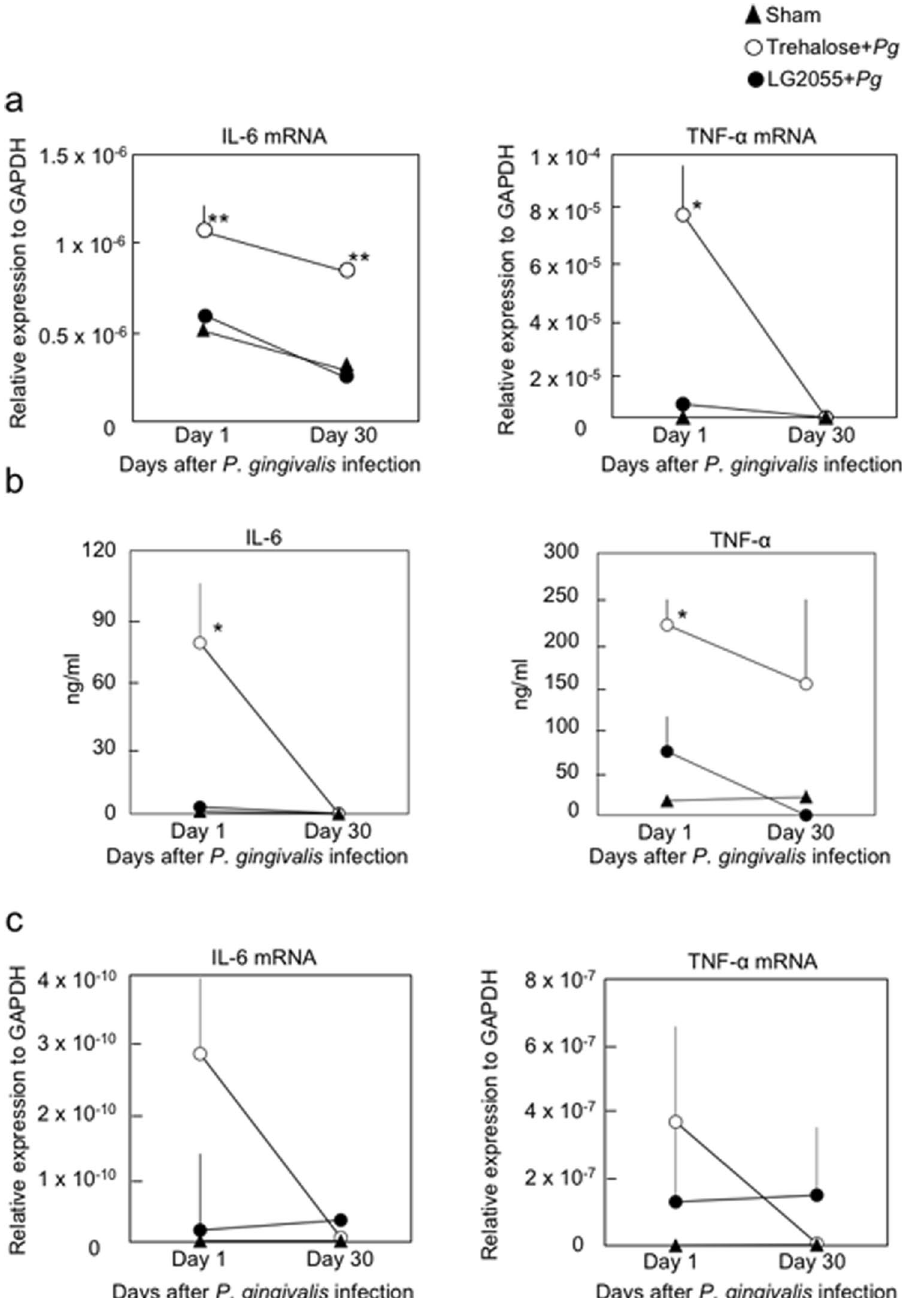
Figure 3. Suppression of the P . gingivalis -induced inflammatory cytokine response in gingival tissues and GMCs by gastric intubation with LG2055. ( a ) Total RNA was extracted from gingival tissue 1 and 30 days after infection with P . gingivalis , and IL-6 and TNF- α mRNA levels were determined using real-time PCR. ( b,c ) GMCs (1 × 10 6 /mL) were isolated 1 and 30 days after P . gingivalis infection, and then cultured for 3 days. ( b ) The culture supernatants were collected and subjected to IL-6- and TNF- α -specific ELISAs. ( c ) The cultured cells were harvested for RNA isolation and quantification of IL-6 and TNF- α mRNA using real-time PCR. All values are presented as the means ± SEM of eight mice per group at each time point; ** p < 0.01, * p <